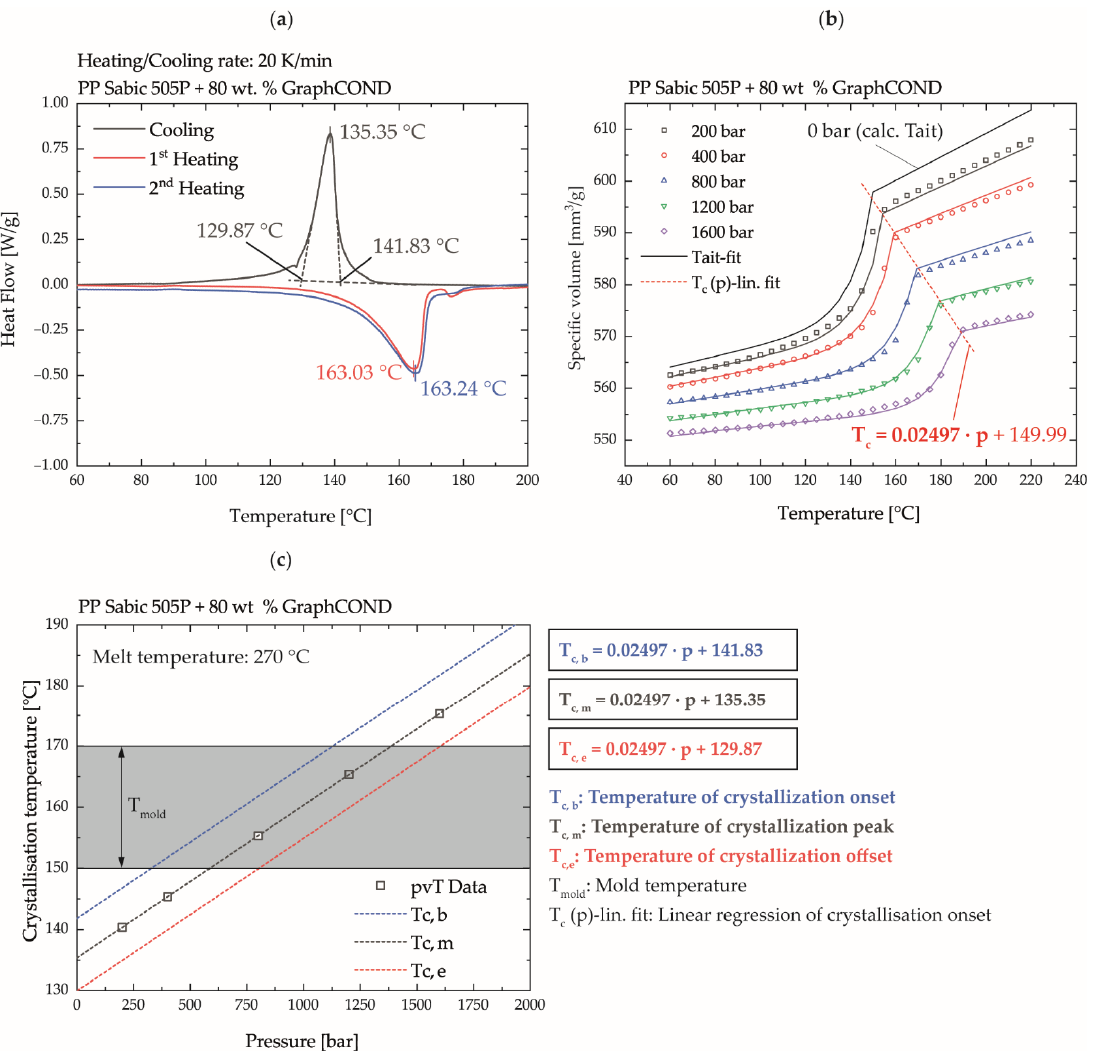
Figure 6. ( a ) Determination of the absolute position of the crystallization range based on DSC meas- urements; ( b ) determination of the pressure dependence of the crystallization range based on pvT measurements; ( c ) combination of the pressure dependence of the crystallization range from the pvT measurements and the absolute position of the crystallization range of the DSC measurements to determine the pressure- and temperature-dependent process window.